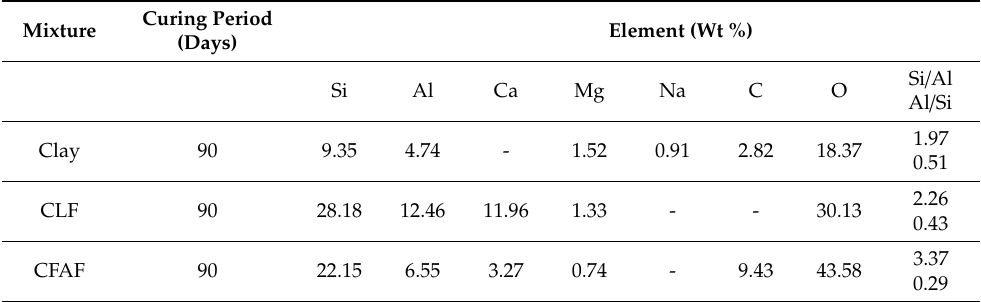
Table 5. EDX Analysis for untreated and treated clay wetting / drying sample after a curing period of 90